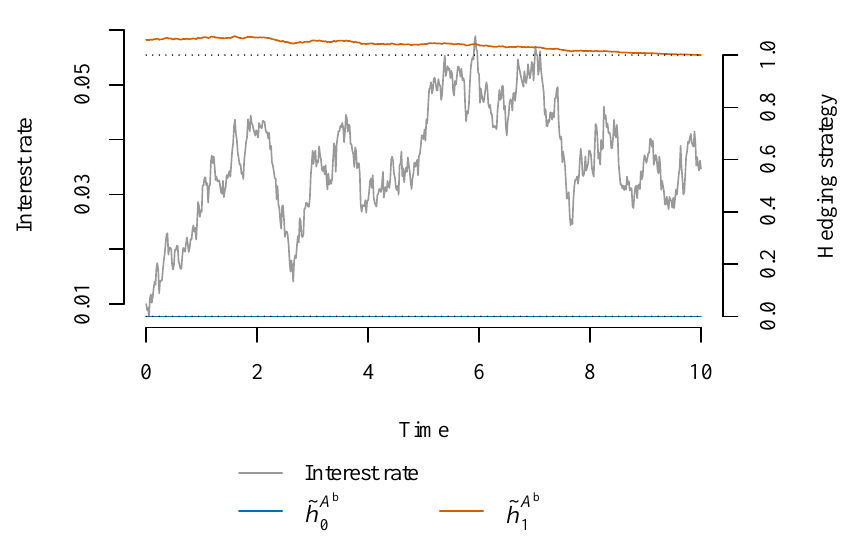
Figure 3. A simulated path for the Vasicek interest rate model (left axis) and the hedging strategy ˜ h A b and ˜ h A b in the presence of taxes and expenses (right axis). As we argued above, here in the Vasicek 1 case, the investment in the bank is zero corresponding to ˜ h A b than one bond, and the difference in value is the value of the tax and expense payments combined.